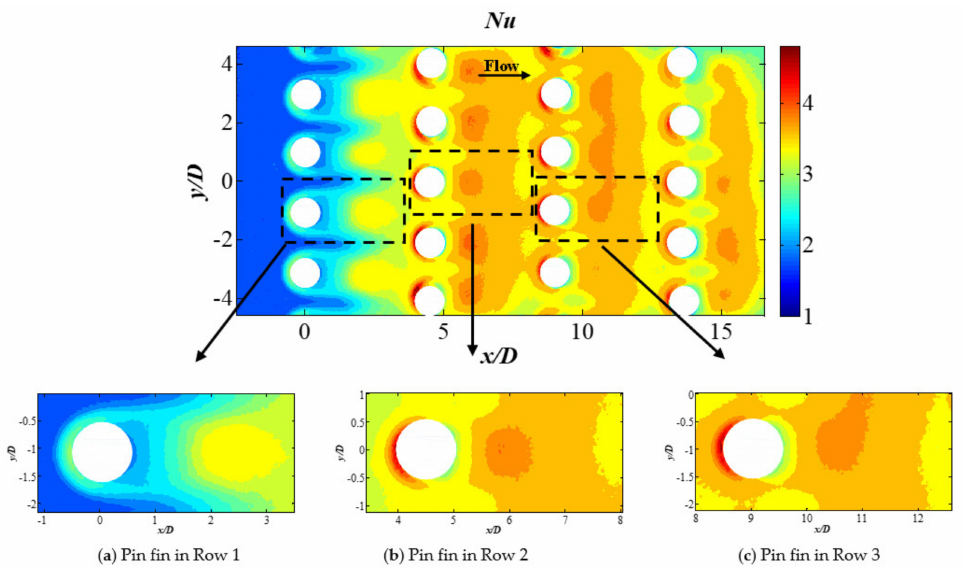
Figure 5. Local distribution of Nu / Nu 0 for Circle pin fins, Re = 10,000. For Row 1, the heat transfer is enhanced right upstream of the pin fin. High heat transfer regions wrap around the pin fin and extend downstream. The shape of the high Nu region indicates that a horseshoe vortex exists around the Circle pin fin, and the local heat transfer is, therefore, enhanced. For Row 2, upstream of the pin fin, the heat transfer is also substantially augmented. However, this high heat transfer region does not extend further downstream. This indicates that the horseshoe vortex around the pin fin of Row 2 is weak, or does not contribute much to local heat transfer enhancement. This is consistent with the observations in Kirsch et al. [25], where the horseshoe vortex is visible in the first row and less apparent in the downstream rows. The relatively high Nu region right upstream pin of Row 2 could also be caused by the thinner boundary layer in this stagnation